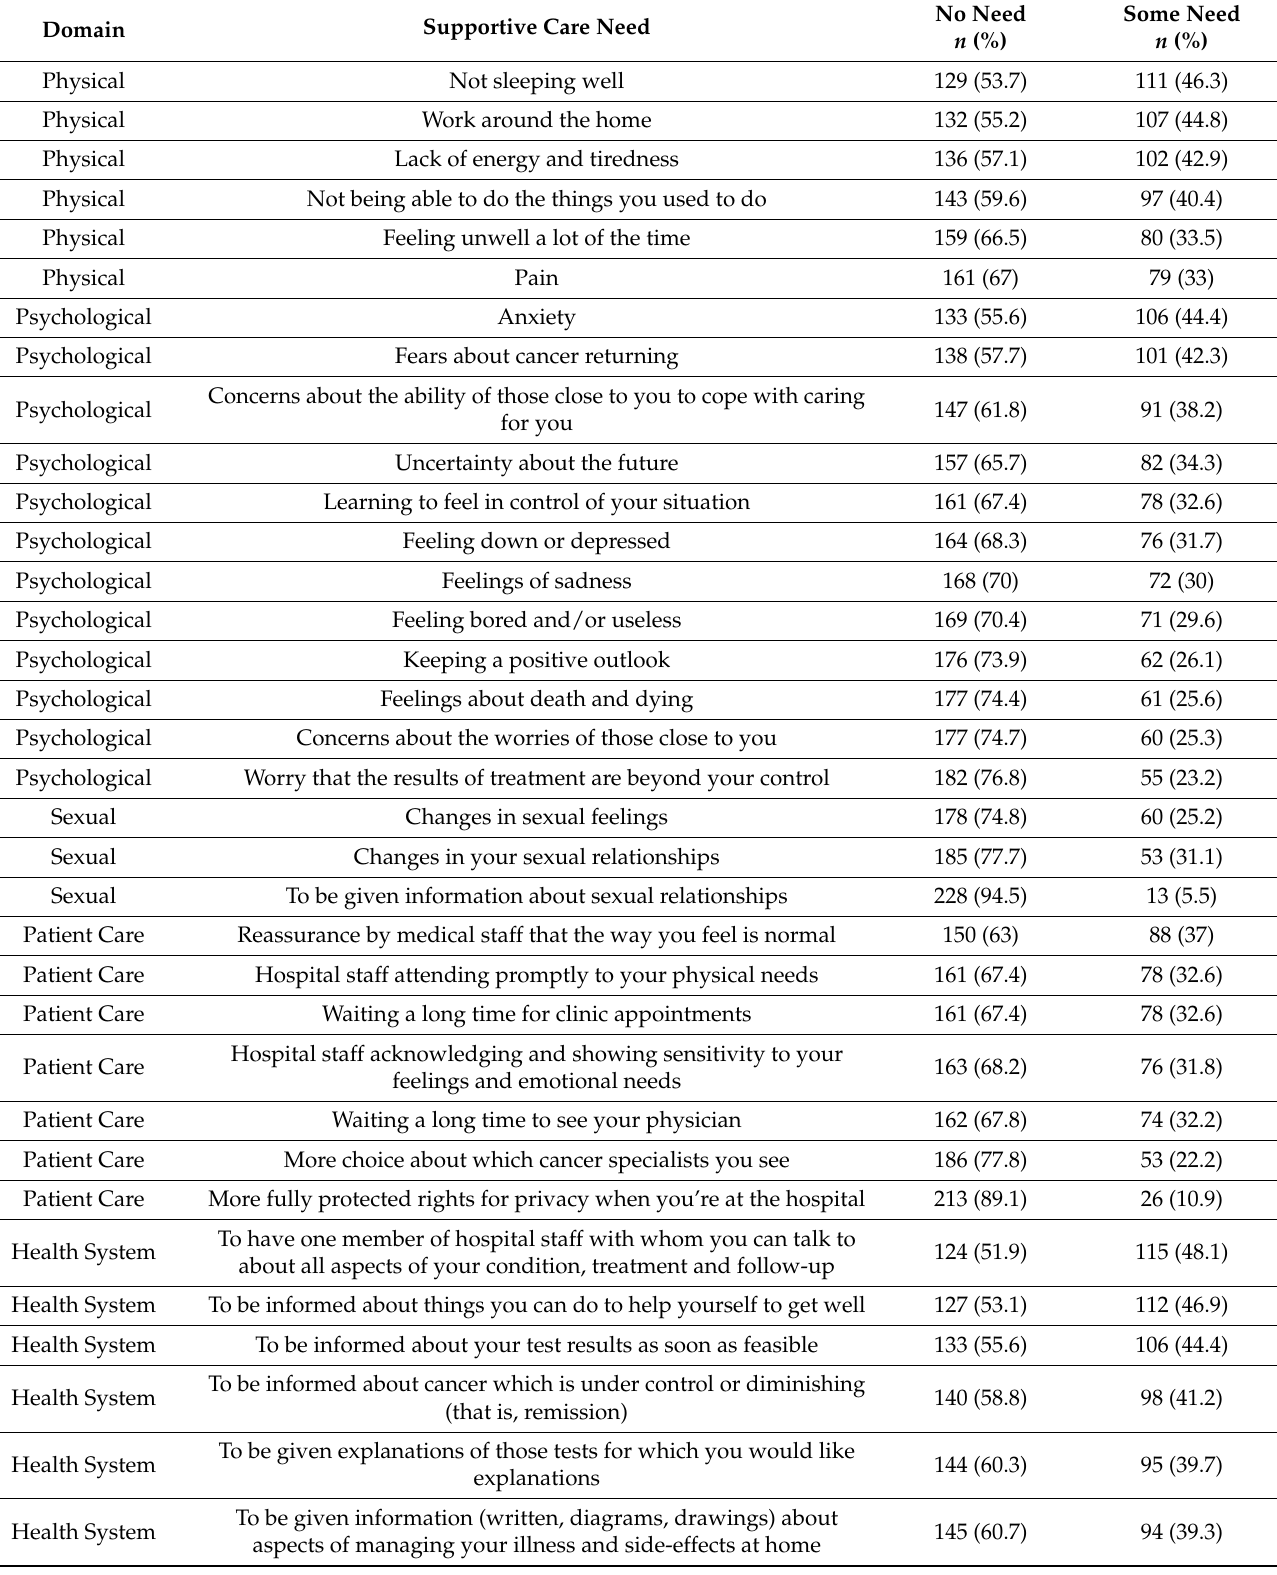
Table 3. Prevalence of Supportive Care Needs among study participants; all questions, 45 items (No Need vs. Some